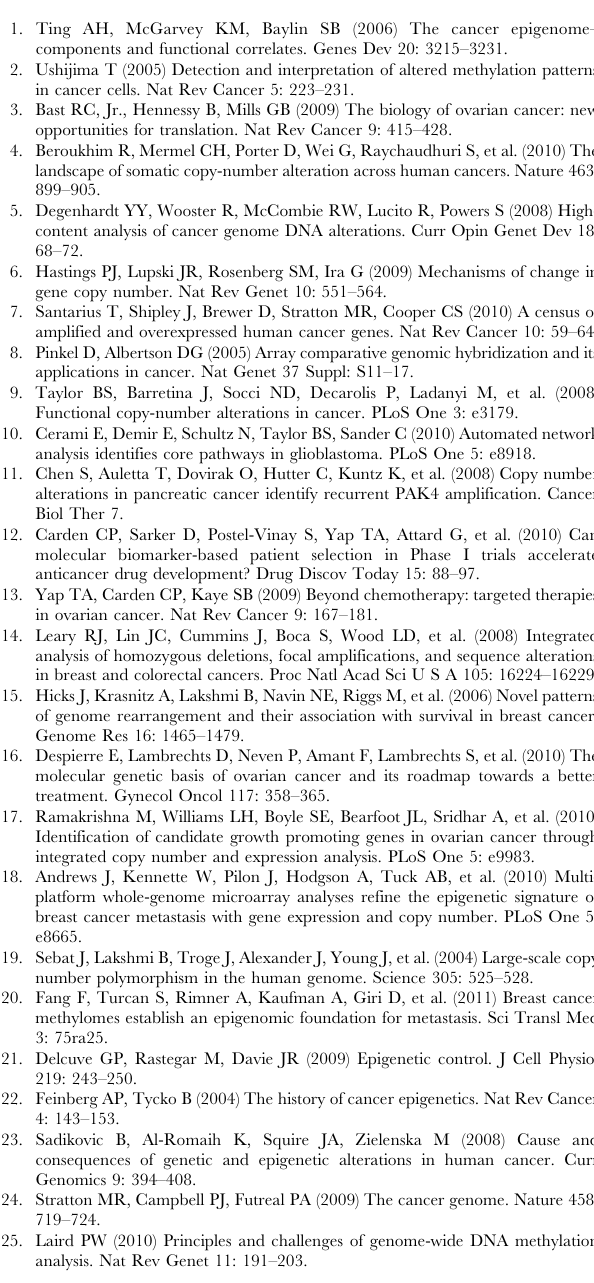
Table S6 Copy number derived methylation and ex- pression of tumor suppressors and oncogenes. Methyla- tion and expression properties per copy number variation (from both the MSKCC and TCGA data sets) a presented for a curated list of known genes implicated in ovarian cancer or shown to be significant in cancer